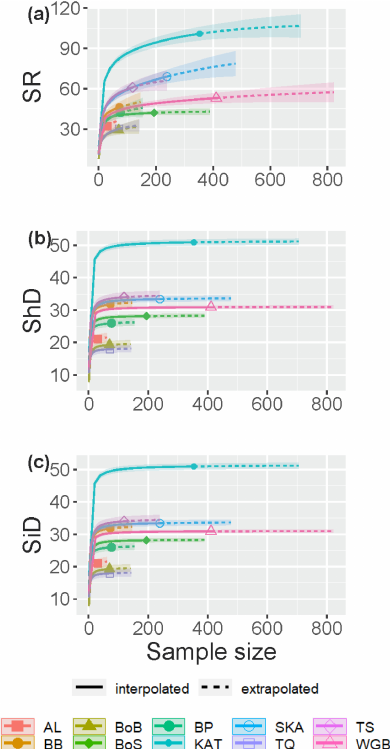
Figure 1. Sample-size-based species accumulation curves showing rarefaction/interpolation (solid curve segments) and extrapolation up to twice the actual sample size (dashed curve segments; Chao et al., 2020) with 95% confidence intervals (shaded areas) for (a) species richness (SR), (b) Shannon diversity (the effective num- ber of frequent species in the assemblage, ShD) and (c) Simpson diversity (the effective number of very frequent species in the as- semblage, SiD) of fish in shallow coastal areas of the 10 assessed sub-basins. The intersection points between solid and dotted lines represent the observed values. Legend acronyms are AL: Åland Sea; BB: Bornholm Basin; BoB: Bothnian Bay; BoS: Bothnian Sea; BP: north Baltic Proper; KAT: Kattegat; SKA: Skagerrak; TQ: